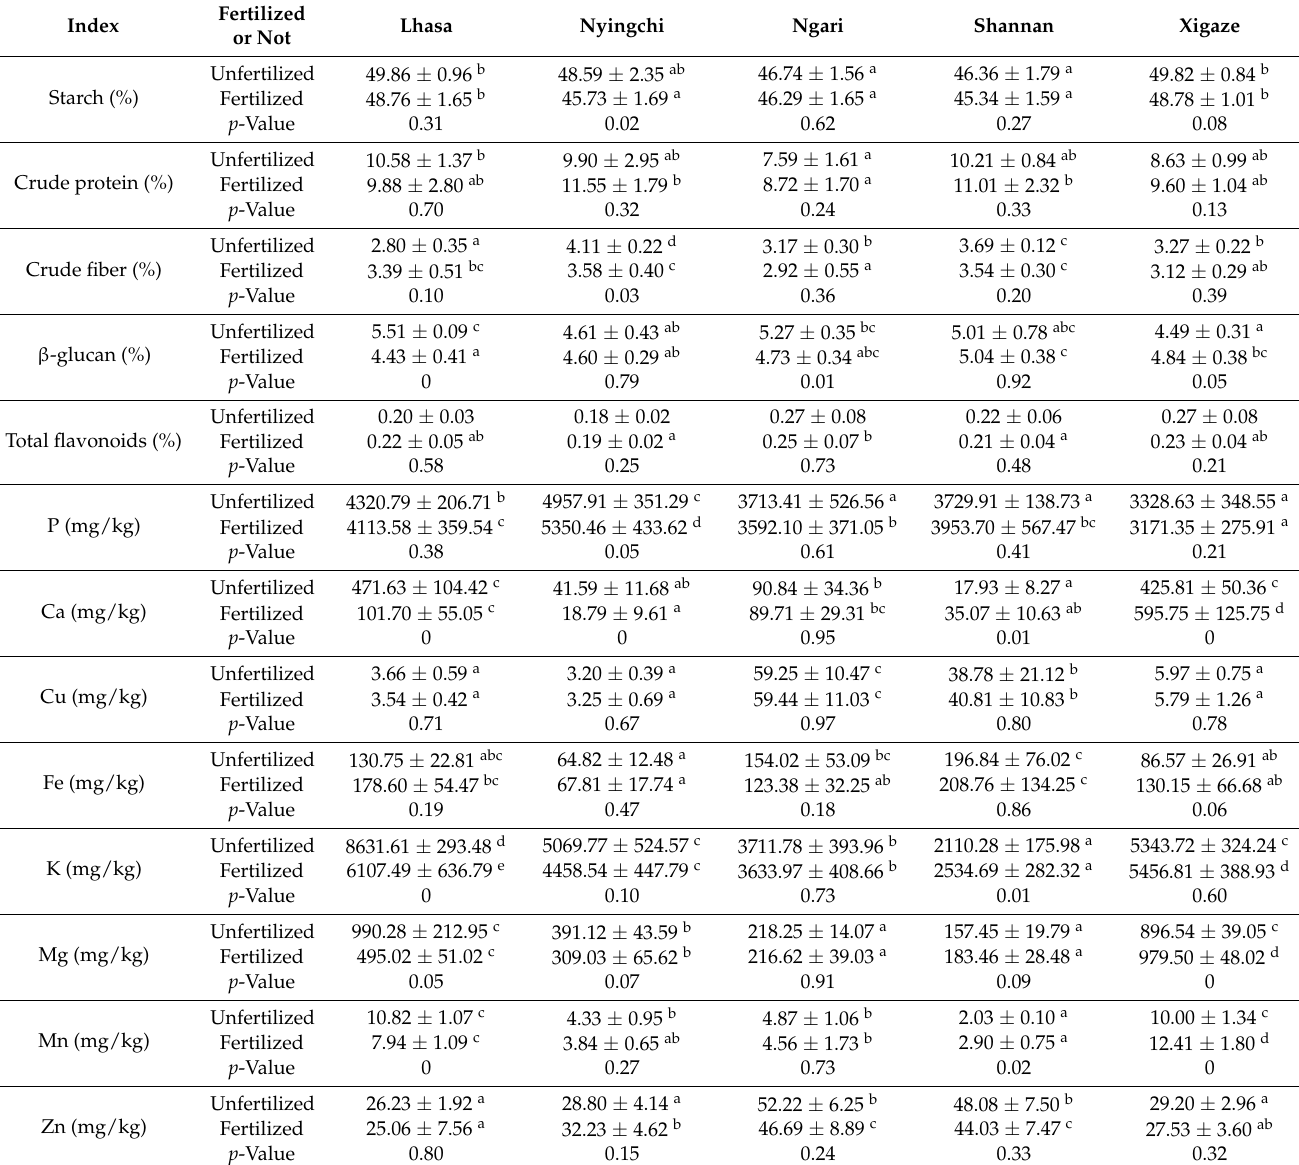
Table 2. Values of nutrients and mineral elements in highland barley from different